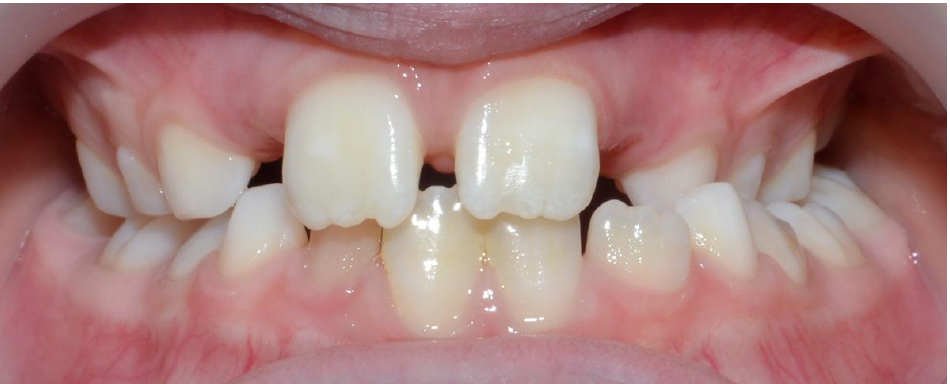
Figure 4. Unilateral posterior crossbite patient in the mixed dentition. Note the asymmetry of the upper and lower jaws.